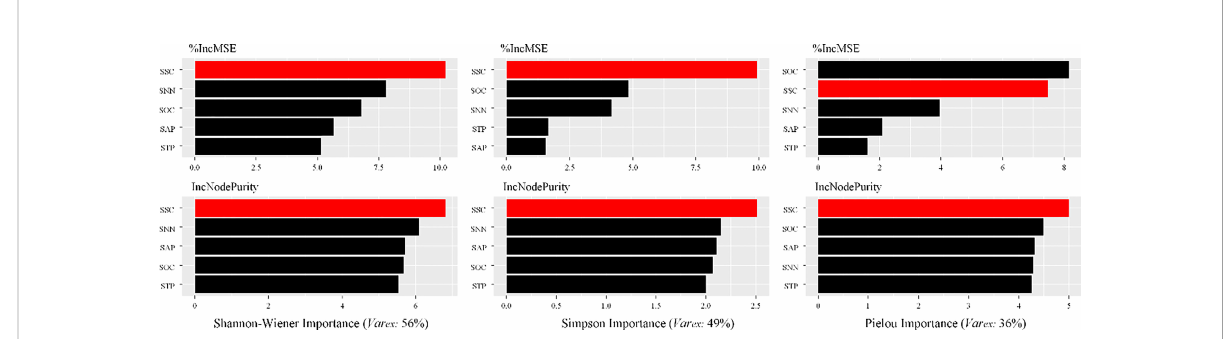
FIGURE 6 Contributions of the soil MDS indicator to the variability of species diversity measured using RF